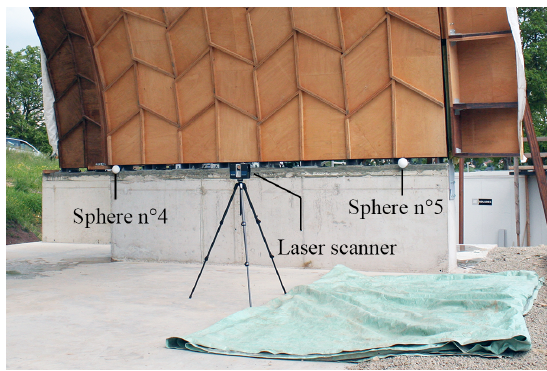
Figure 7. Spheres n° 4 and 5 and 3D laser scanner FARO ® Focus S